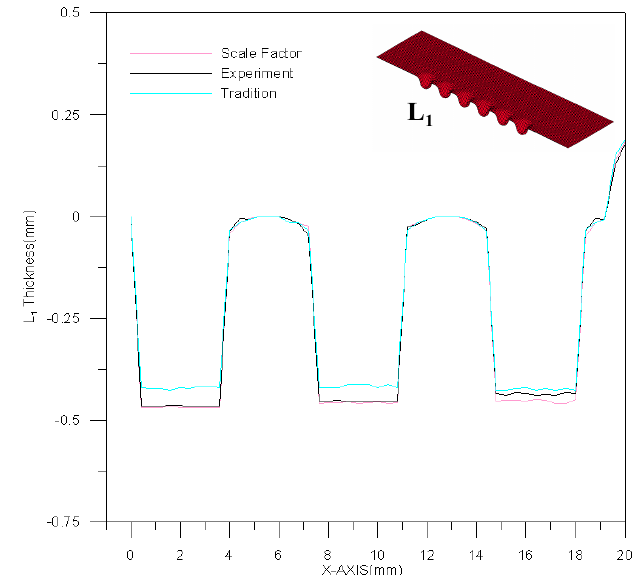
Figure 11. The contour comparison of L 1 section.